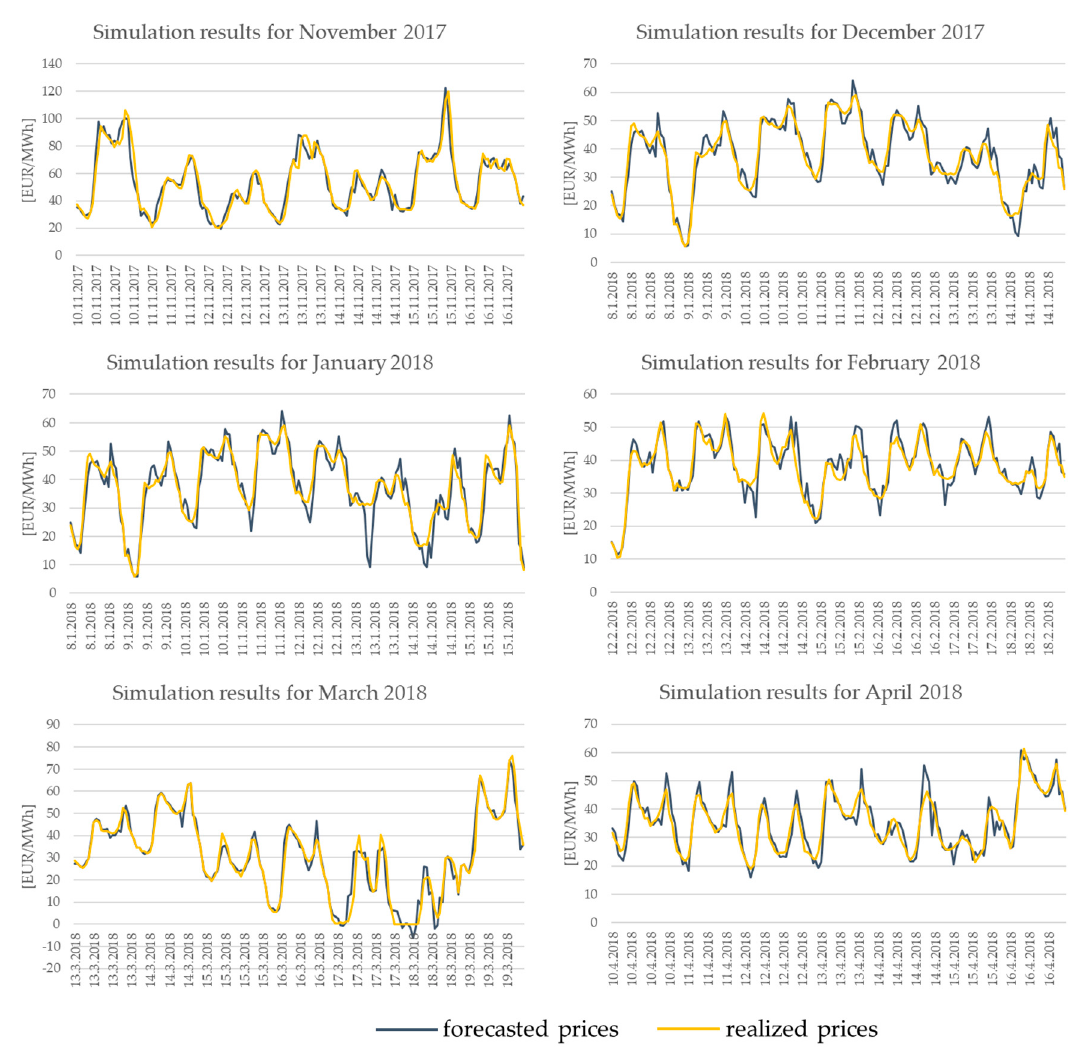
Figure 22. Forecasted and actually realized hourly prices in third forecasting interval for the period from November 2017 to April 2017. from November 2017 to April